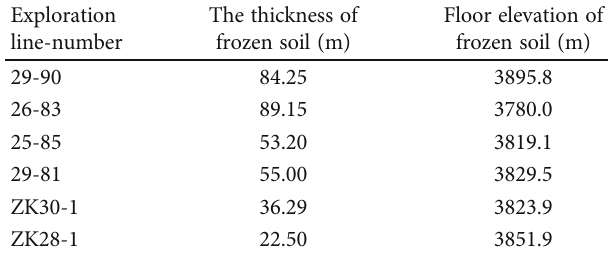
Table 1: Statistical table of the thickness of permafrost layer drilled in the NMT mine fi